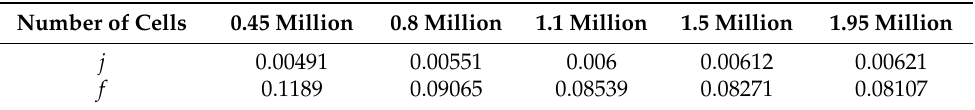
Table 3. Grid independence